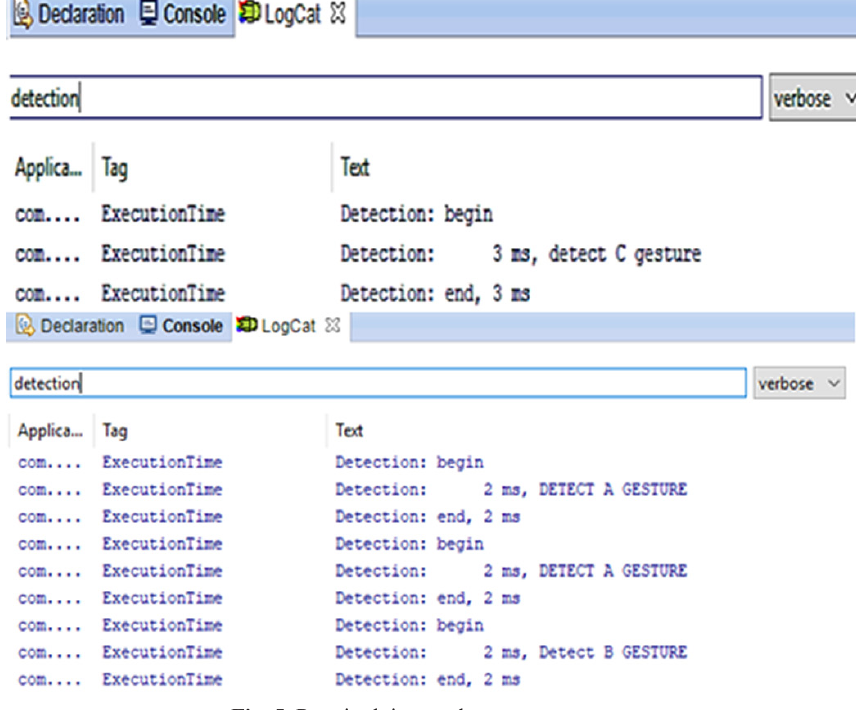
Fig. 5. Required time to detect some